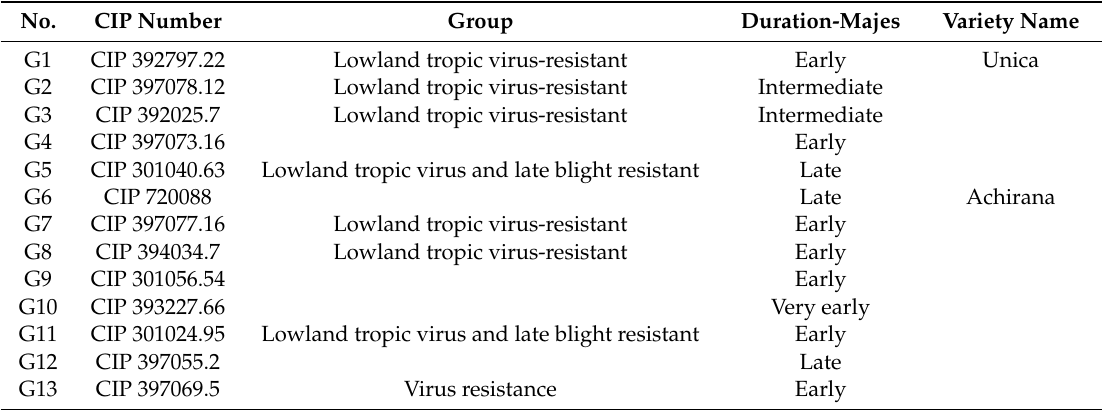
Table A2. Genotype tested in this study. The duration to physiological maturity as determined